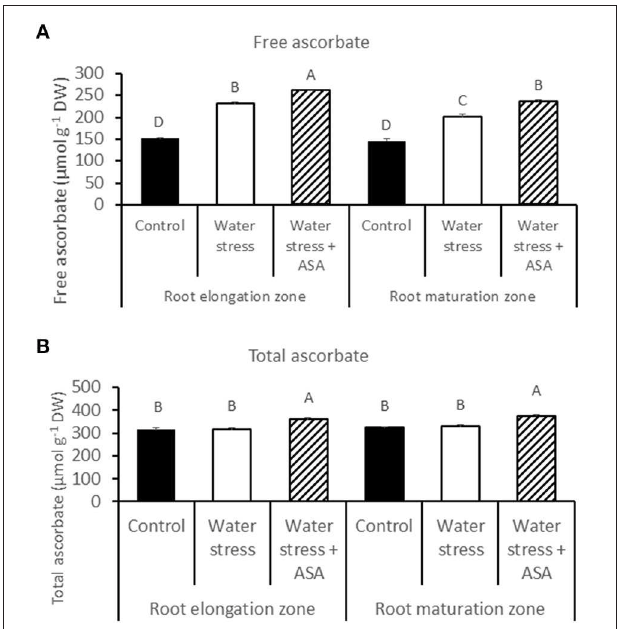
FIGURE 5 | Free (A) and total (B) ascorbate content in tall fescue roots exposed to non-stress control, water stress, and water stress with ASA treatment. The data represent mean ± SE ( n = 4 replicated pots of plants and each pot with multiple plants). Columns marked with the same letter are not significantly different at p < 0.05 .